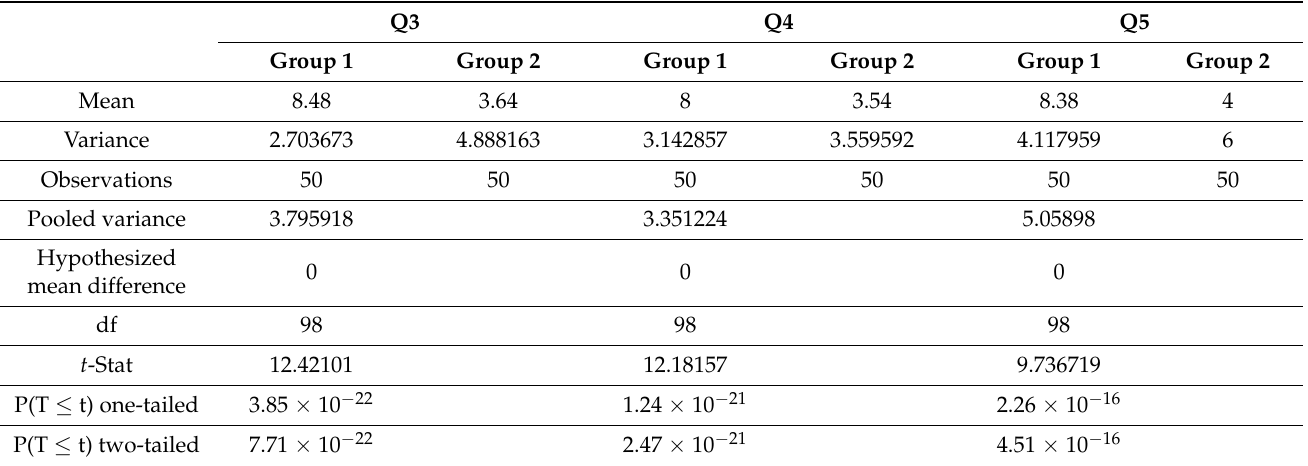
Table 4. The t -test